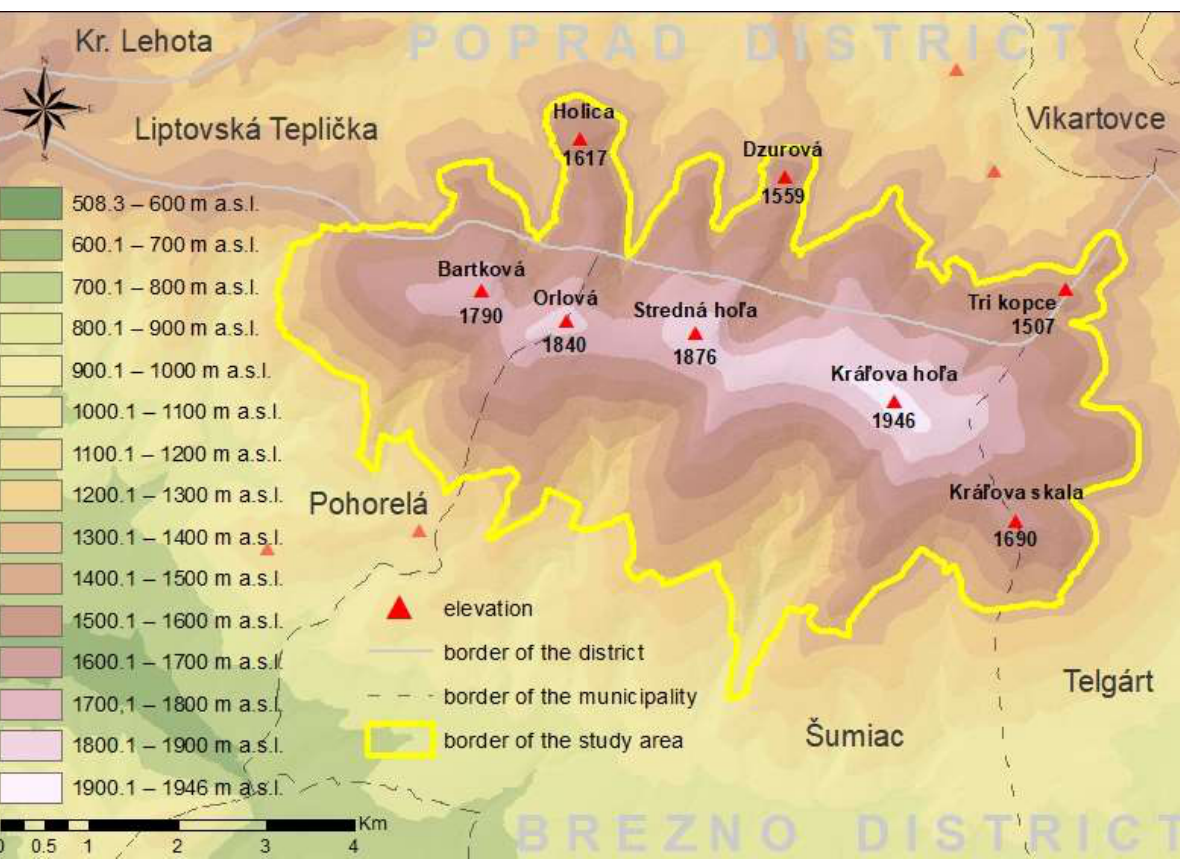
Figure 2. Hypsometric conditions of the studied area within the administrative boundaries. Source: The Geodesy, Cartography and Cadastre Authority of the Slovak Republic.